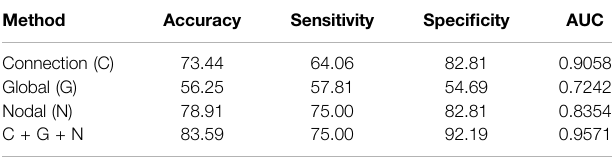
TABLE 7 | Classi fi cation performance corresponding to different methods.